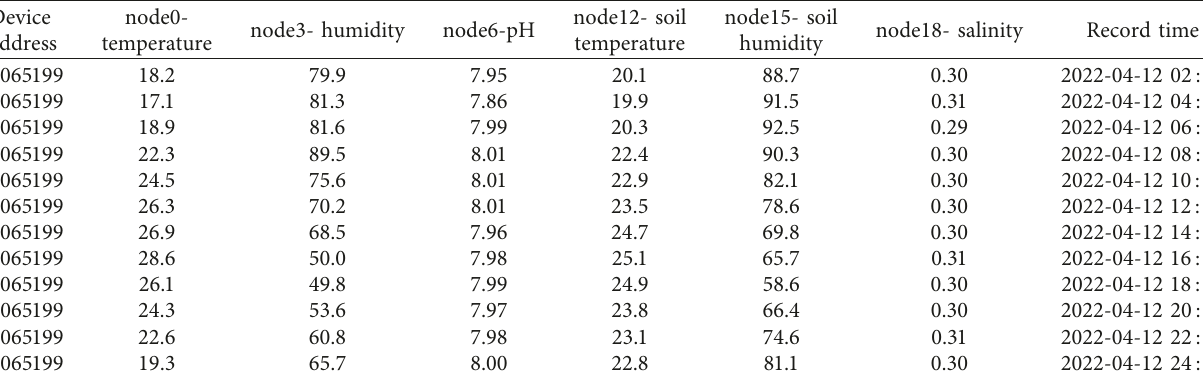
Table 5: Historical data